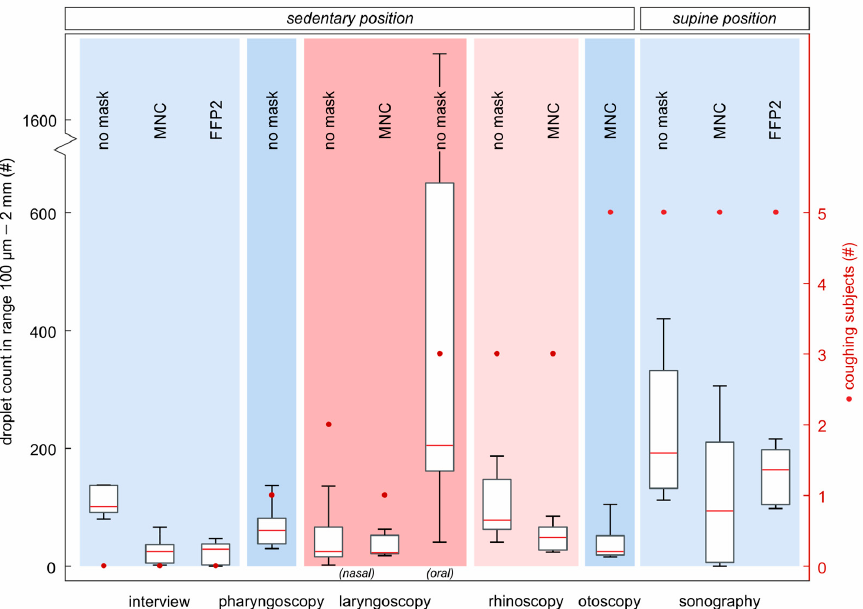
Figure 5. Boxplots of all 13 tasks, divided into sedentary und supine position tasks. The procedures are shown on the x -axis. The detectable droplet count, ranged between approx. 100 µm and 2 mm, is shown on the left y -axis and corresponds to the boxplots. The right y -axis shows the number of subjects coughing during the respective task.